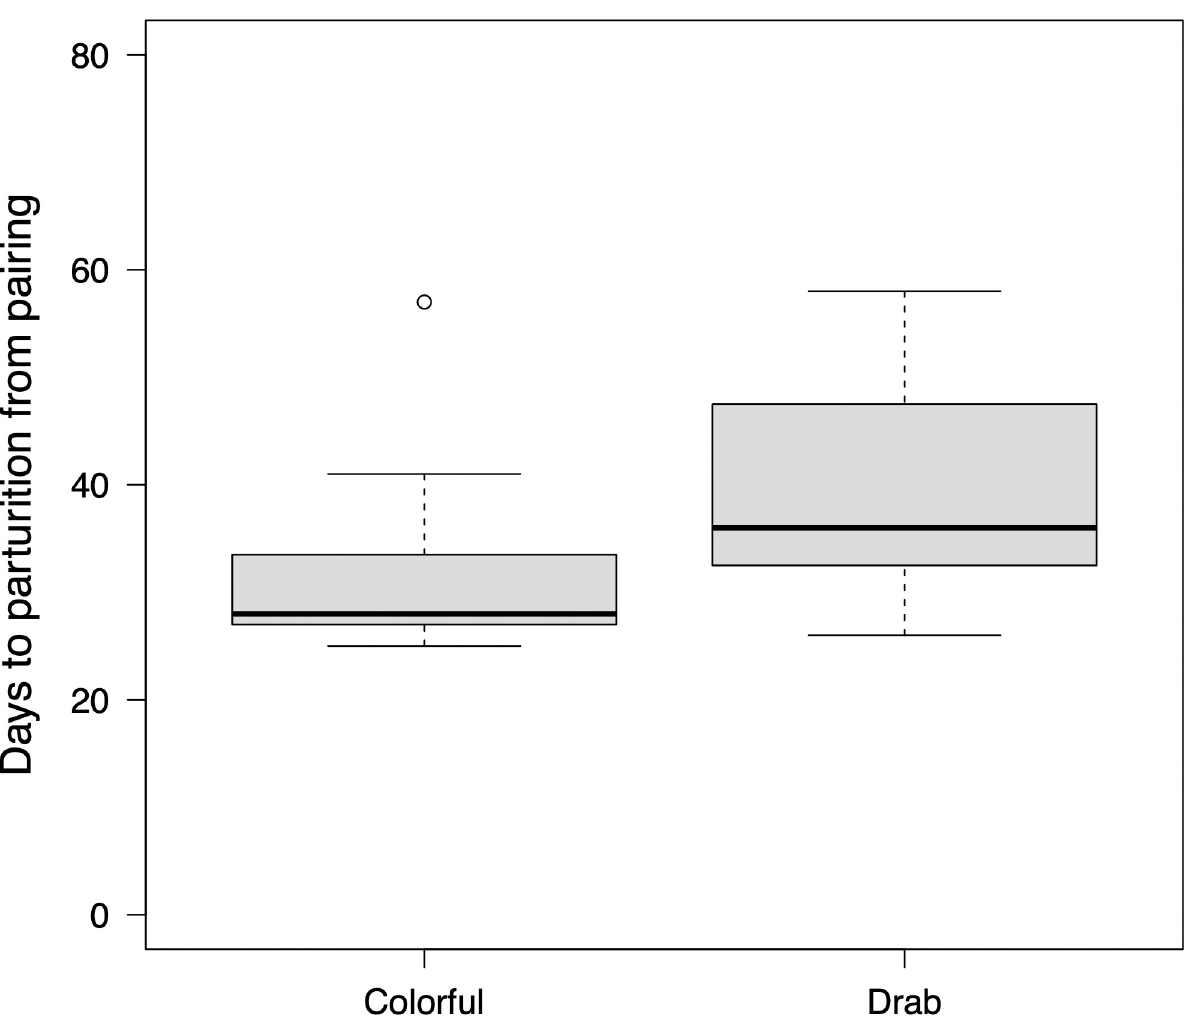
Fig 2. Male coloration and female gestation period. Boxplots of gestation period when females paired with colorful males (sample size n = 23) and females paired with drab males (n = 23). The gestation period indicates values before transformation.